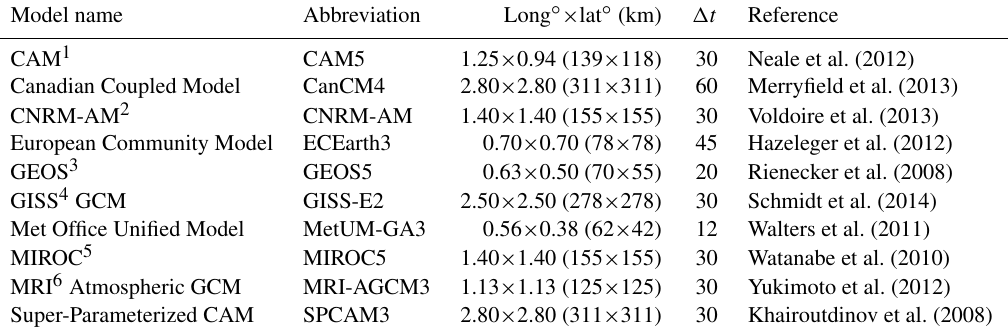
Table 1. For each model from the “Vertical structure and physical processes of the Madden–Julian Oscillation” project from which time step rain rates are used: the model name, the institution that produced the data, the horizontal resolution at the Equator in degrees (to the nearest 0.01 ◦ ) and the equivalent in kilometers, the model time step ( (cid:49)t ) in minutes and a reference with further details. Models are ordered alphabetically by